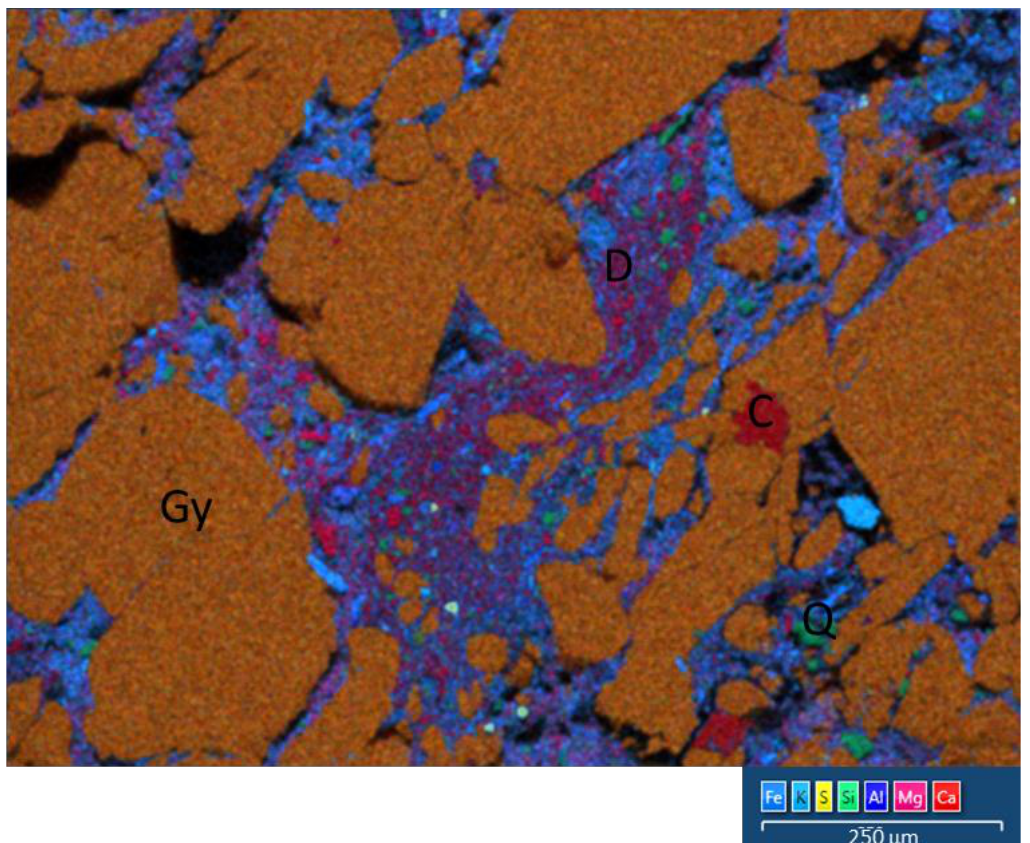
Figure 6. SEM-EDS map of a portion of the rock, showing the presence of a dolomite cement (purple) interdigitated to the fine-grained terrigenous material (light blue) .